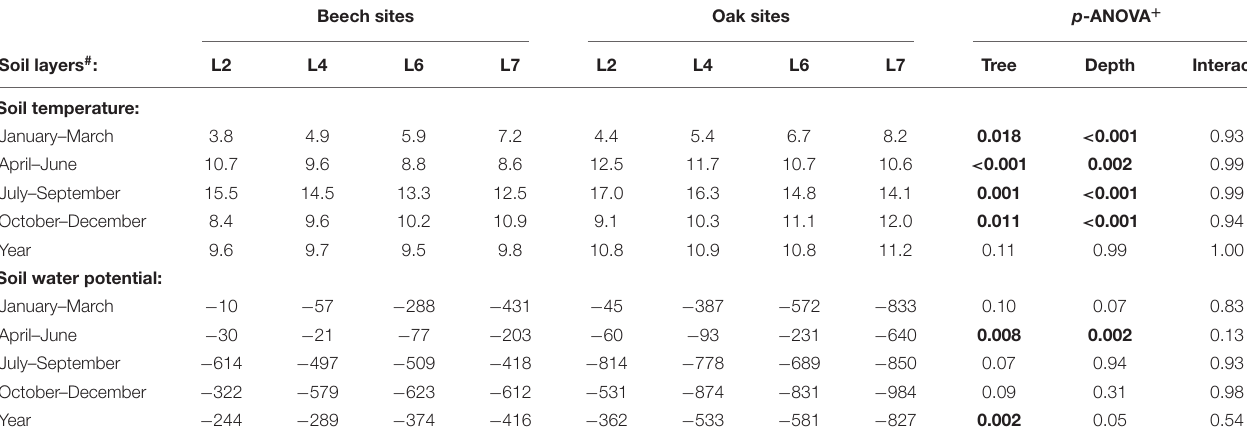
TABLE 2 | Mean values of soil temperature ( ◦ C) and soil water potential (kPa) in 2015 (L2, L4, L6: n = 3 forest sites; L7: n = 2 forest sites). Beech sites Oak sites p -ANOVA + Tree